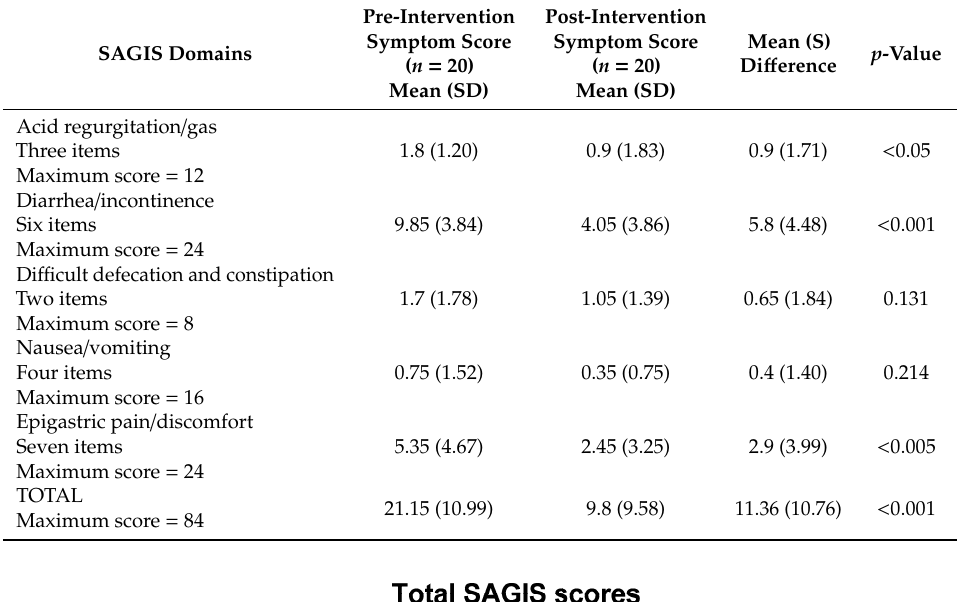
Table 2. Mean di ff erence for Structured Assessment of Gastrointestinal Symptoms (SAGIS) domains from baseline to follow-up. Comparisons were made by two -tailed paired samples t -test. Data shown represents the mean di ff erence and standard deviation (SD).